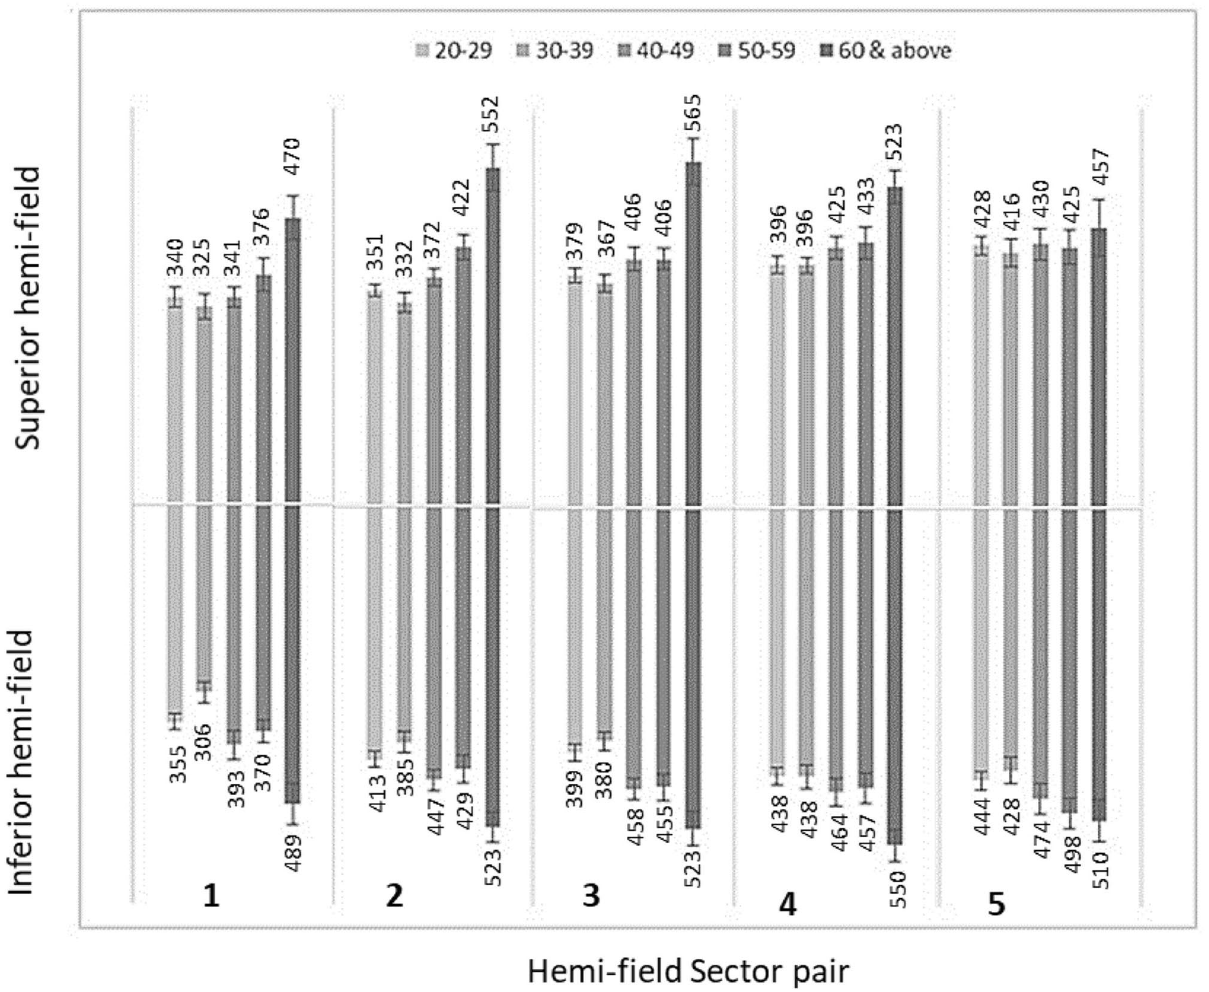
Figure 2. The SRT behaviour in Hemi-field sectors among healthy subjects; The mean SRTs with corresponding standard error was plotted among healthy eyes in different age groups between 20 and 60 years and above for stimulus intensity 214 cd/m 2 . SRT showed symmetrical behaviour across the age groups in eye movement perimetry. Foster et al .